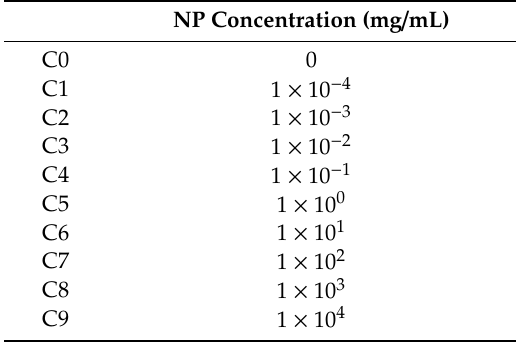
Table 3. Hyaluronic acid-chitosan nanoparticle (HA-CS NP) experimental